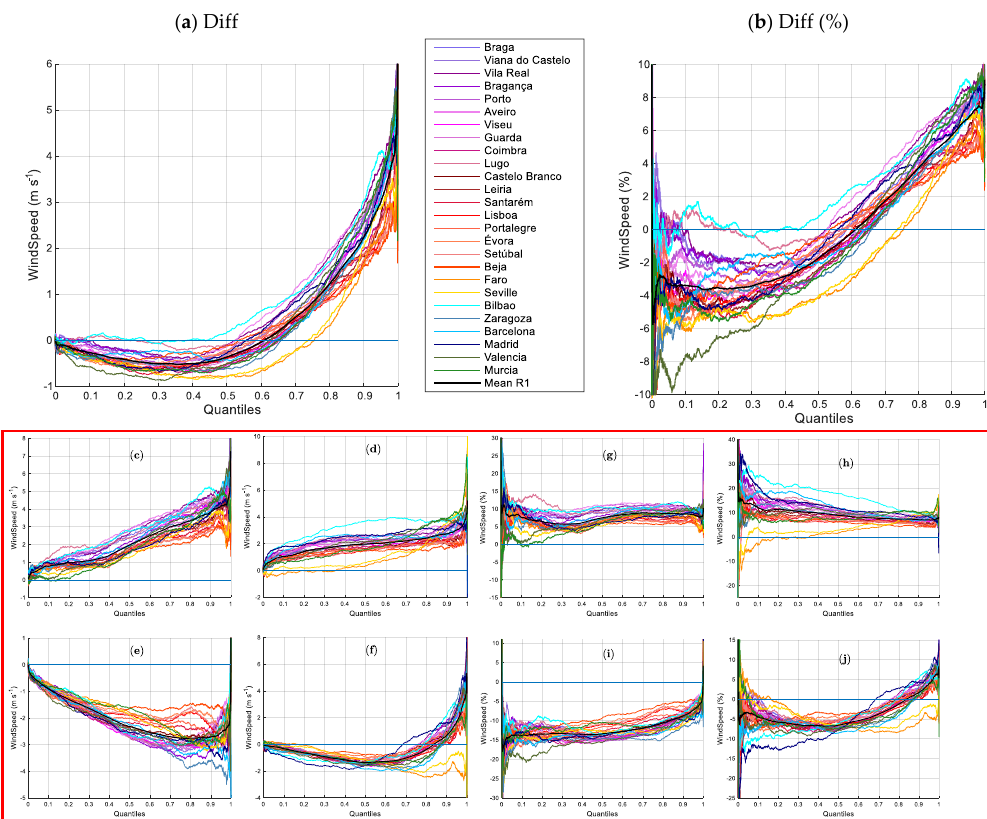
Figure 12. Differences (future-historic) for wind speed at 300 hPa for annual and seasonal conditions, as a function of the quantiles of the corresponding empirical distributions. ( a ) Absolute differences (m s −1 ) and ( b ) relative percentual differences (%). Seasonal absolute differences are also represented for ( c ) winter, ( d ) spring, ( e ) summer and ( f ) autumn, and Seasonal percentual differences for ( g ) winter, ( h ) spring, ( i ) summer and ( j ) autumn. The black line (Mean R1) refers to the mean of region 1 (total area).